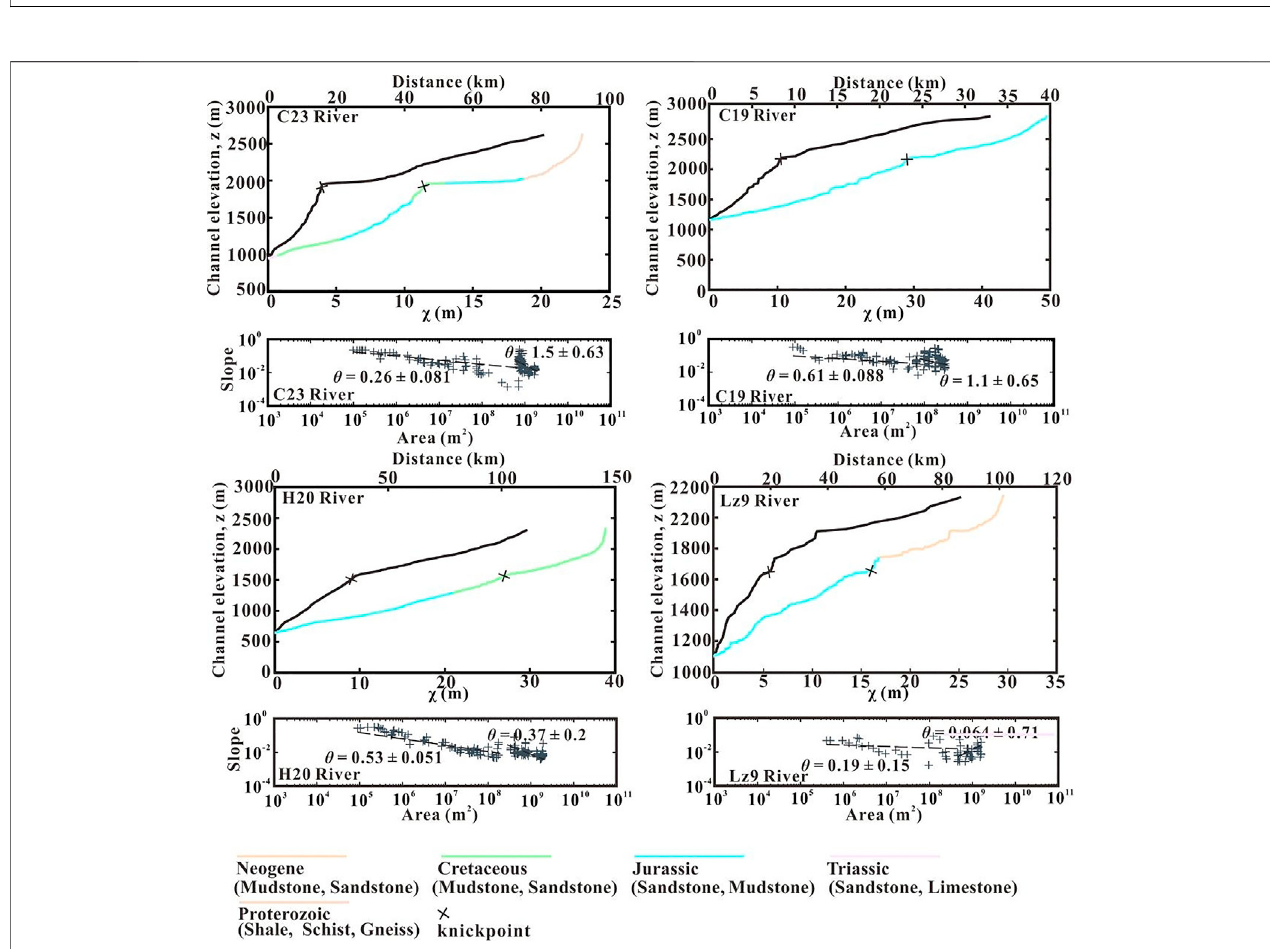
FIGURE 6 | Stream pro fi le analysis for the four middle-scale rivers. The colored curve is a river pro fi le with variable lithologies.